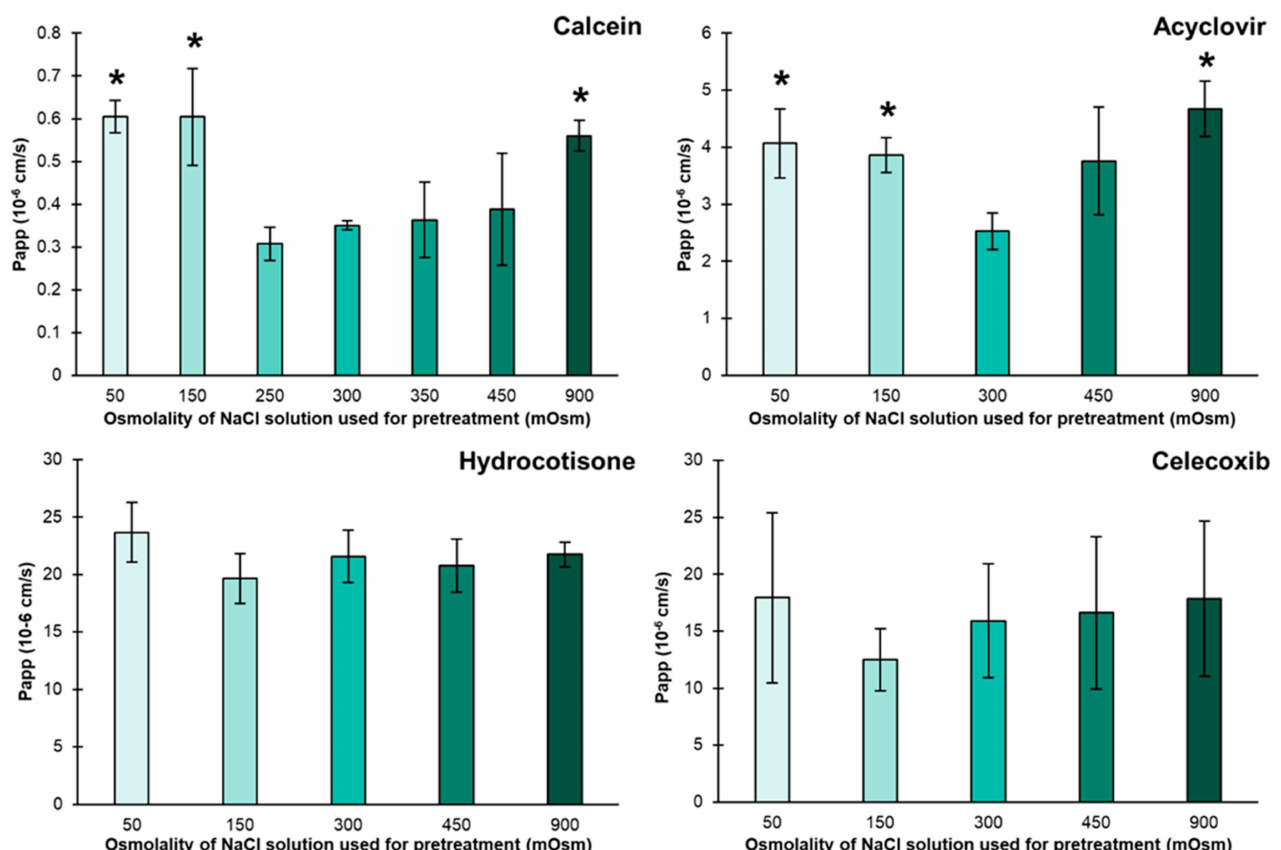
Figure 1. Permeation of calcein, acyclovir, hydrocortisone, and celecoxib across PermeaPad ® in 300 mOsm PBS after 30 min pretreatment of the barrier with NaCl solutions of different osmolalities. Mean ± SD ( n = 3). * Indicates a significant difference ( p < 0.05) as compared to the barriers pretreated with a 300 mOsm (isotonic) NaCl